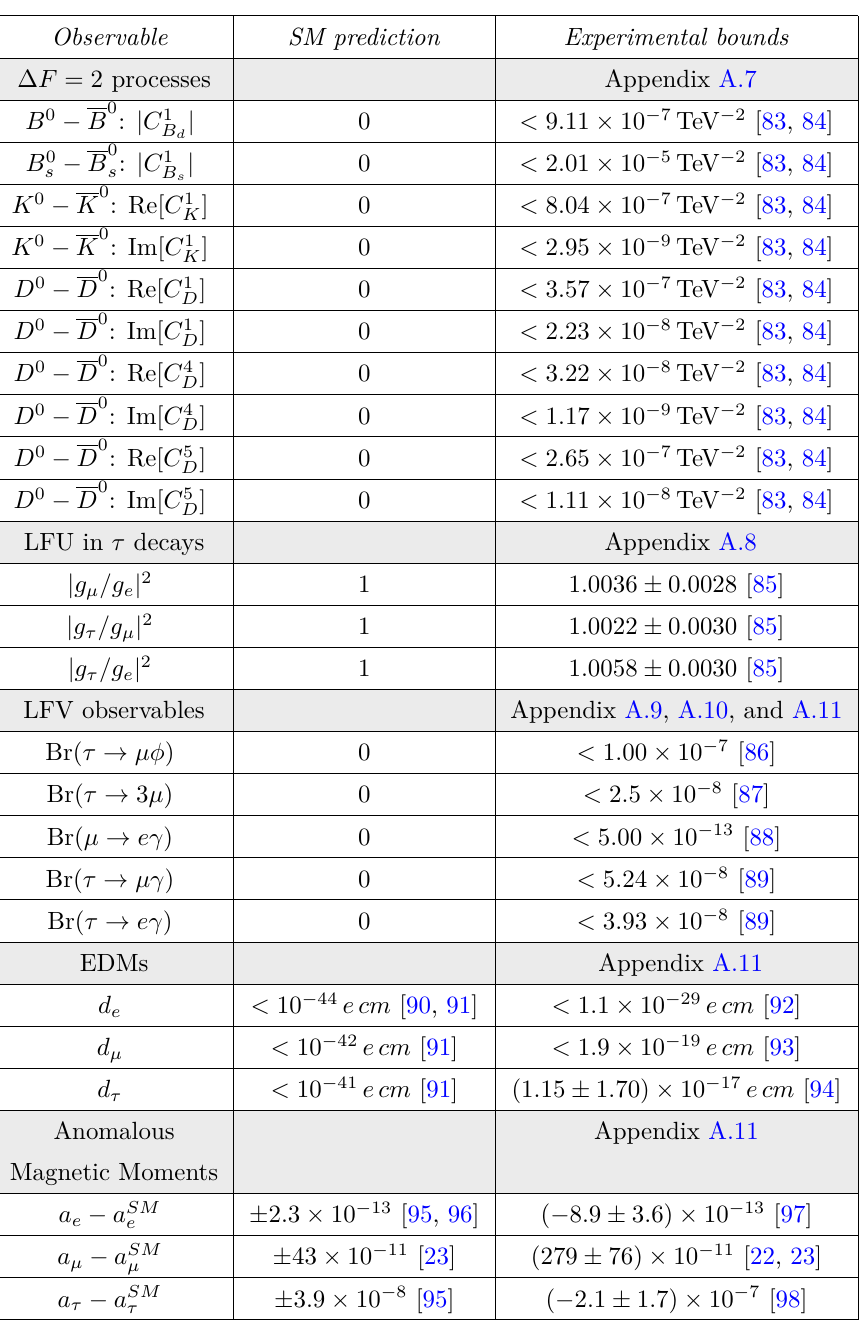
Table 2 . Meson-mixing and leptonic observables, with their SM predictions and experimental bounds. Upper limits correspond to